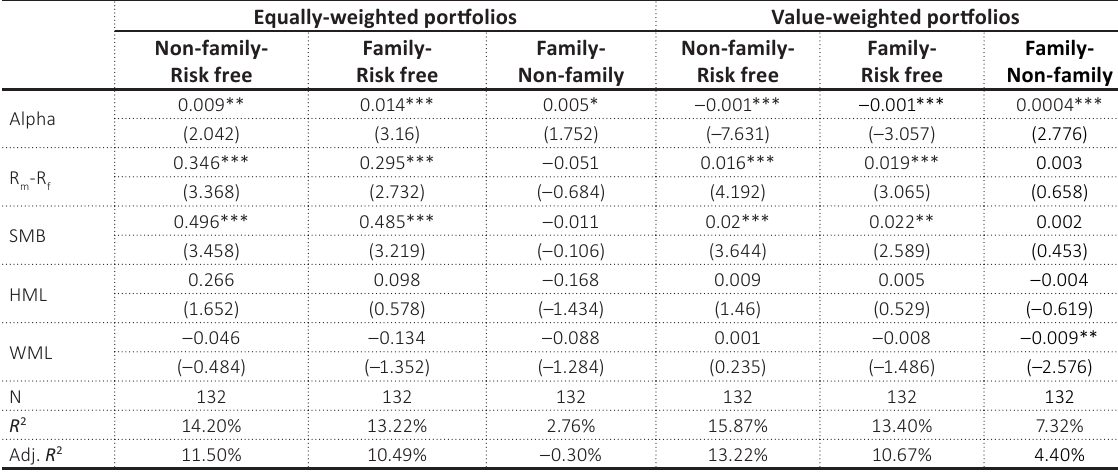
Table 4. Four-factor